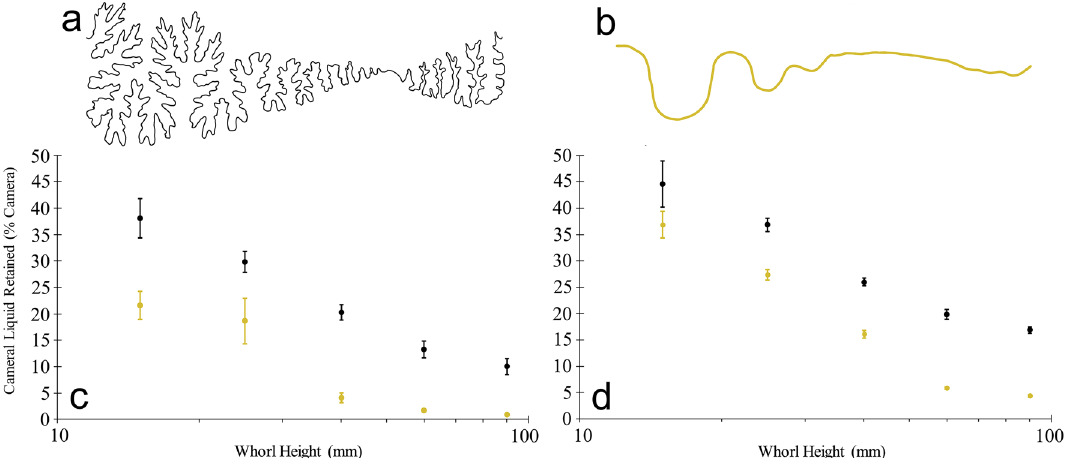
Figure 4. Liquid retention within the 3D printed chamber models of Damesites sp. (derived from the CT scan data of Inoue and Kondo 63 ). ( a ) Suture pattern (left hemisuture shown) recorded from Damesites sp. ( b ) Suture pattern from ( a ) after smoothing to reveal only first order folds. ( c ) Cameral liquid retention (average percent camera at various scales) in the complex and simple Damesites models without hydrophilic coating. ( d ) Cameral liquid retention in both models with hydrophilic coating. Whorl heights are dorsoventral lengths measured in the center of the camerae. The black and gold datapoints correspond to models with complex and simple sutures, respectively. Error bars represent one standard deviation (n =